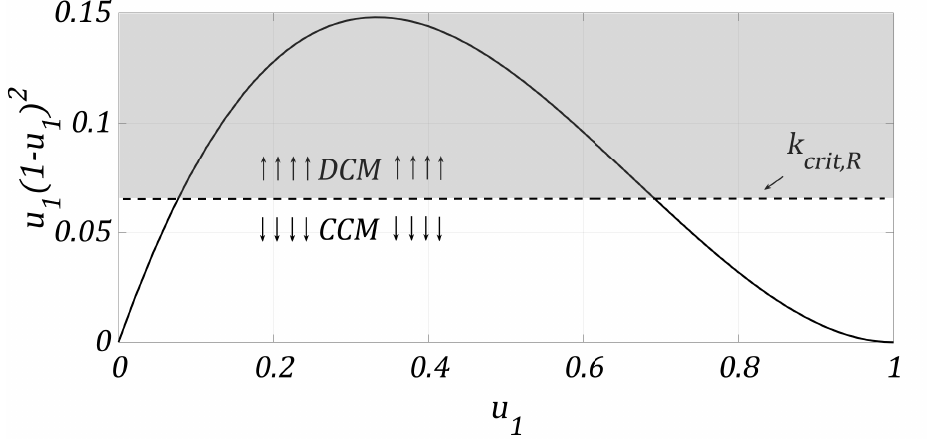
Figure 2. DCM/CCM dependence on u and k crit , R